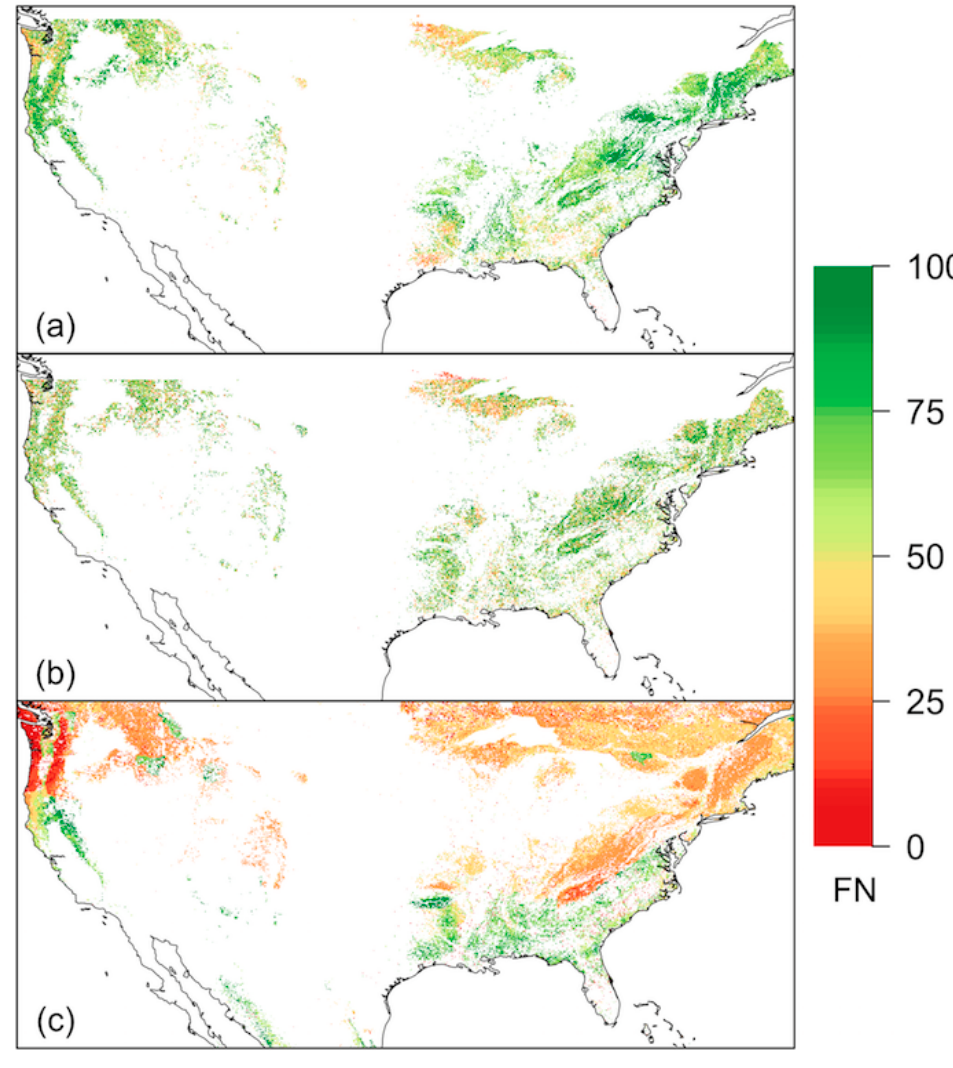
Figure 14. The spatial similarity map between our global wall-to-wall forest AGB product and the products from ( a ) Blackard et al. (2008) [76]; ( b ) Saatchi et al. (2005) [77]; and ( c ) Reusch & Gibbs (2008) [73] in the U.S. forest area.